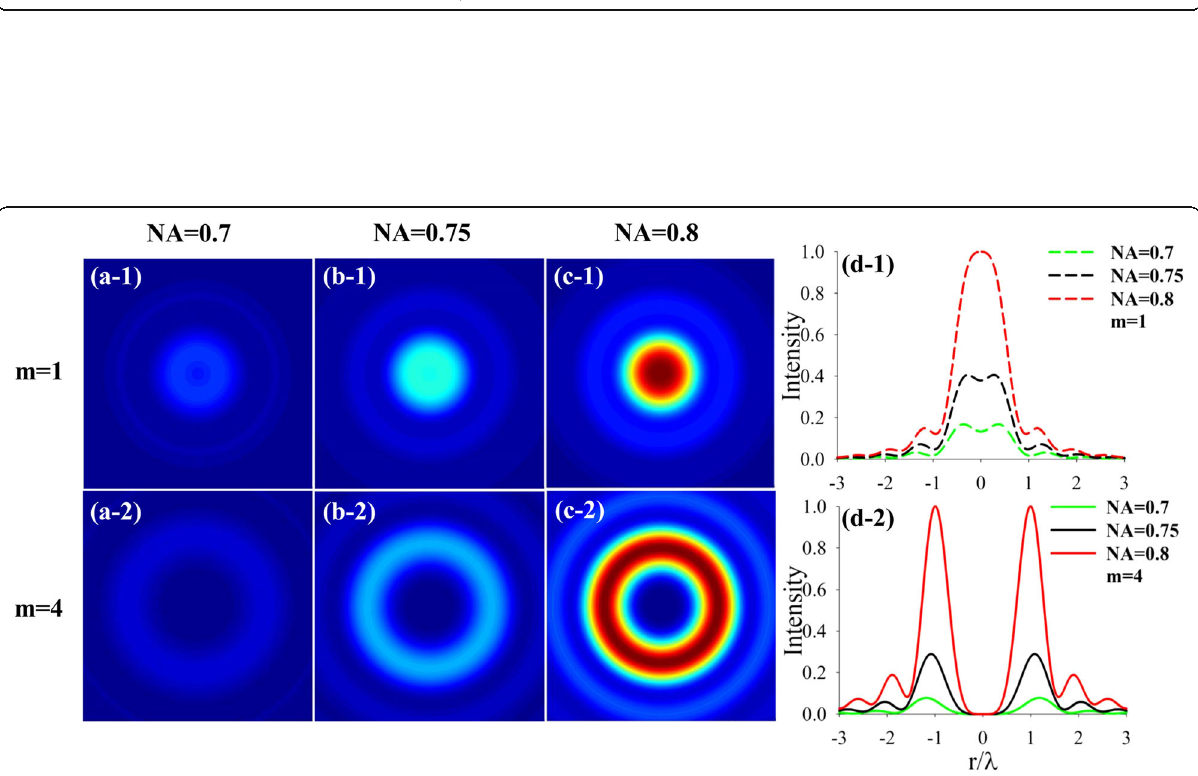
Fig. 2 Intensity profile for the tightly focused left-hand CPAVBs with m = 1 for different beam orders. a-1 to a-3 , b-1 to b-3 , and c-1 to c-3 are the total intensity | E | 2 and longitudinal | E z | 2 and radial | E ρ | 2 components, respectively